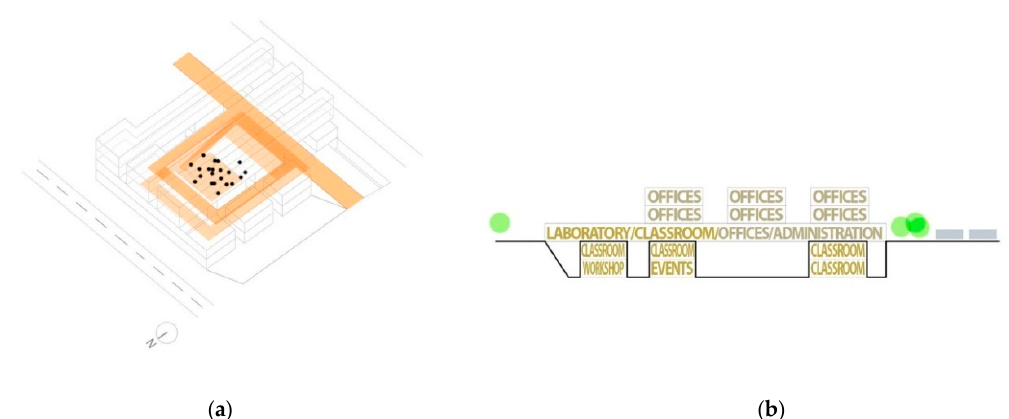
Figure 6. HPS IV: main circulations scheme ( a ) and cross-section ( b ). Drawings: Carlos Pastor García.